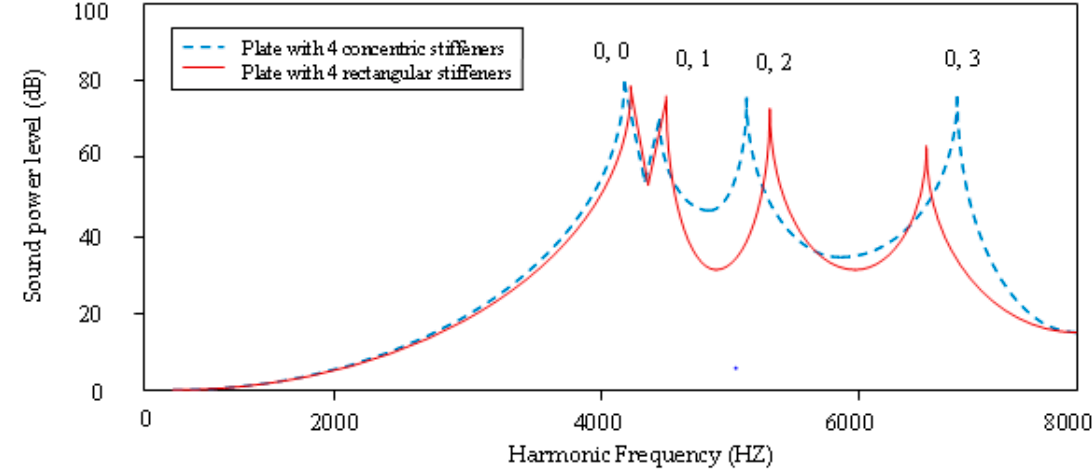
Figure 27. Numerical comparison of sound power level (dB) for annular plate attached with 4 rectangular and 4 concentric stiffener patches having parabolic decreasing thickness variations (Case I) for taper ratio T x = 0.75.